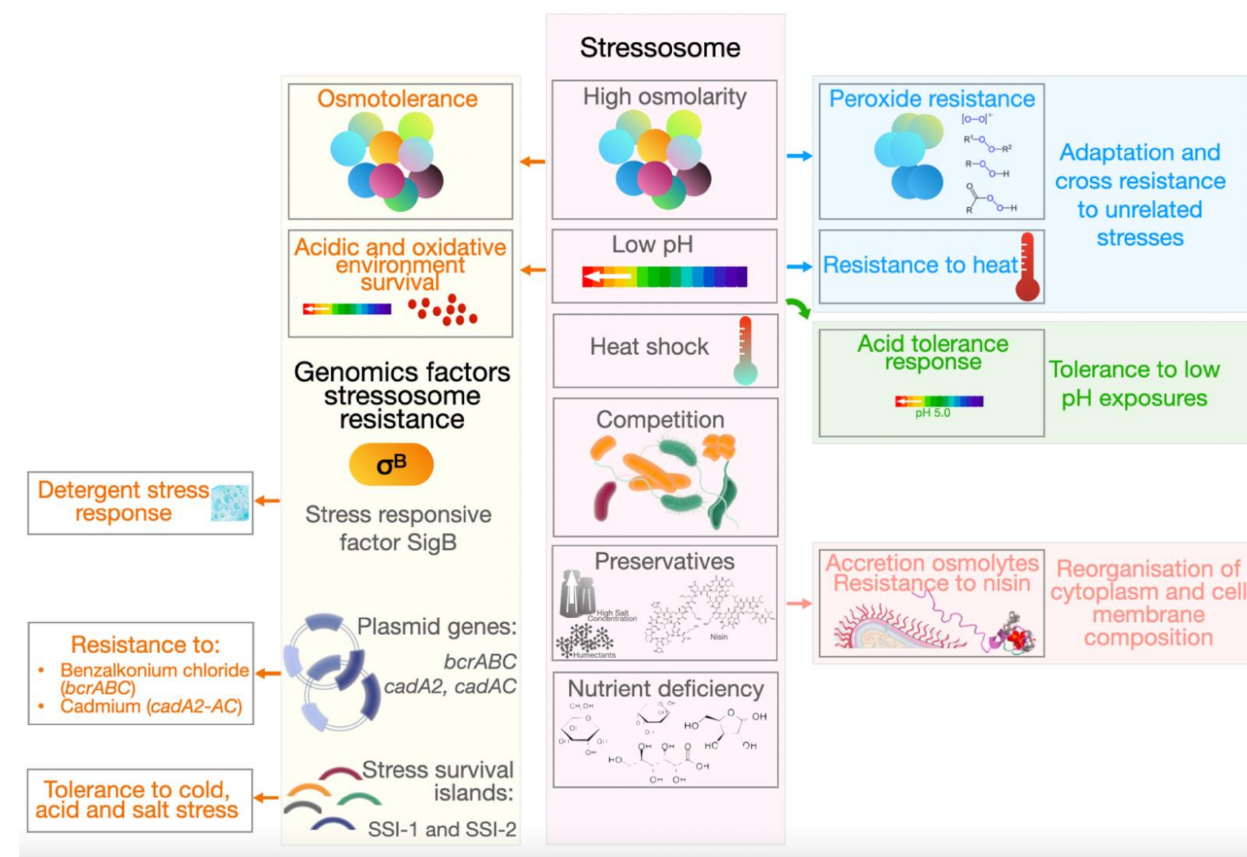
Figure 1. L. monocytogenes adaptation to stress conditions (stressosome) involves various genomic factors and causes different adaption